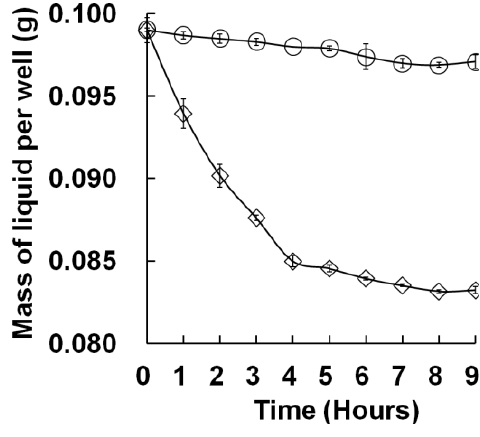
Figure 5. Sample evaporation of cell-free medium in Parafilm ® -sealed 96-well microplates; ( ◇ ) shaken at 600 rpm with amplitude 3 mm; ( ○ ) swivel of M96SS at a rotation rate of 20 rpm. Each sample was repeated four